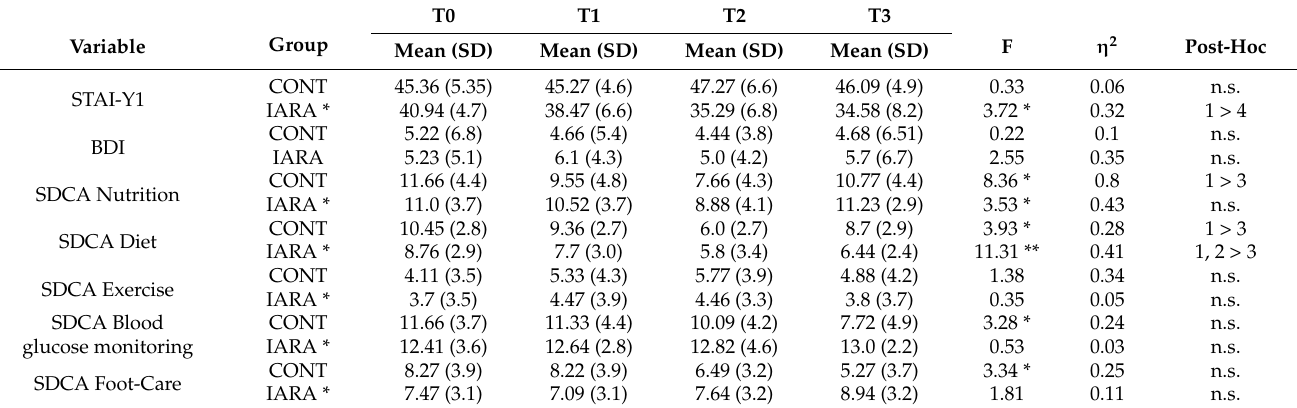
Table 2. Results of one-way repeated measures ANOVA with Bonferroni post-hoc test.